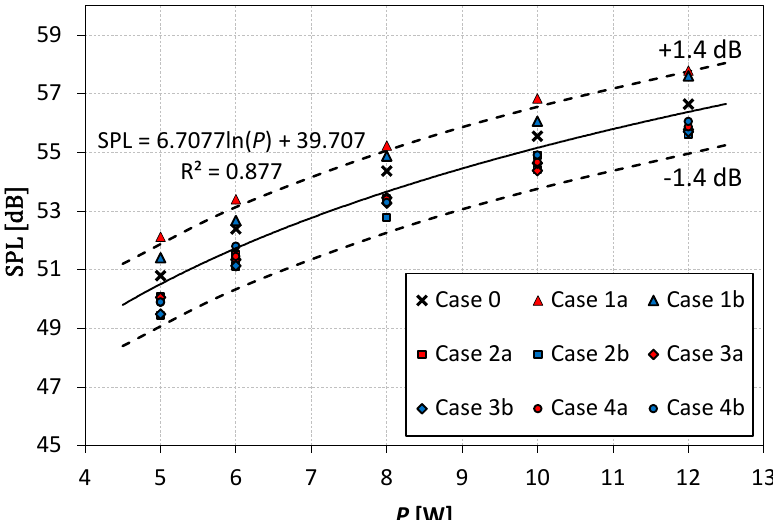
Figure 7. Sound pressure level (SPL) vs. real power.